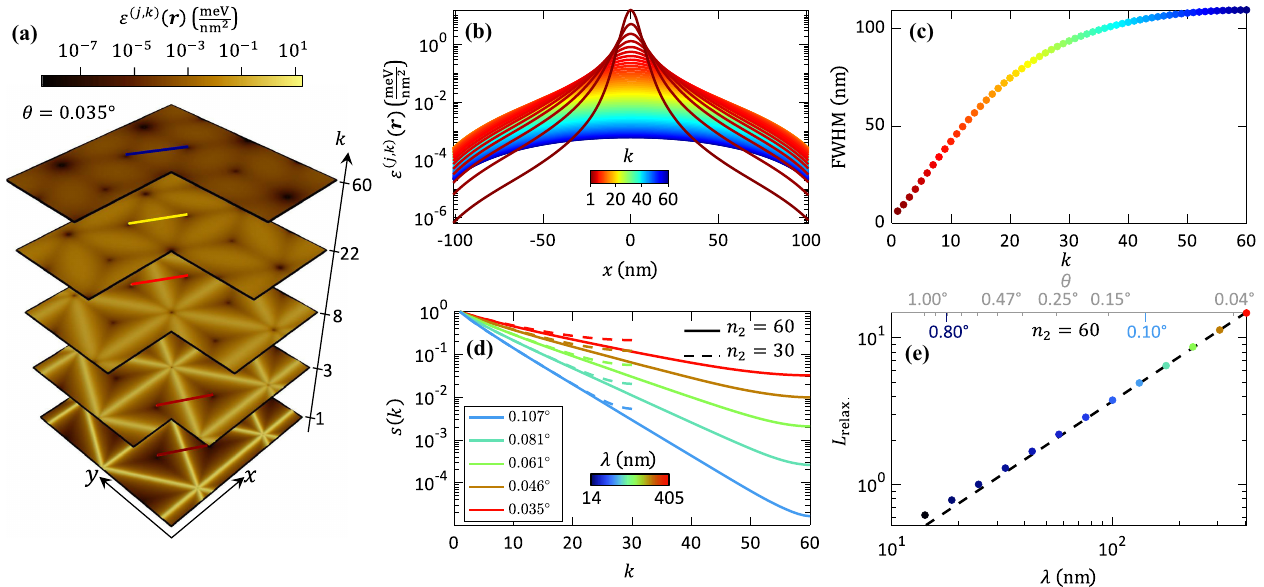
FIG. 4. Multilayered relaxation in twisted-graphite interfaces (a) Elastic energy density in representative layers for an n 1 ¼ n 2 ¼ 60 graphite-on-graphite structure with a twist angle θ ¼ 0 . 035 °. (b) Domain-wall profiles and (c) width as full width at half maximum (FWHM) for different layers showing the broadening and weakening of the relaxation away from the interface. Layer number indicated by color bar in (b). (d) Decay of the strength of the relaxation process away from the interface for different twist angles as captured by the displacement field scaling factor (see text for details). Two layer thickness cases are considered. (e) The penetration depth extracted from (d) as a function of the moir´e period λ . The penetration depth is shown to be proportional to the moir´e period (dashed